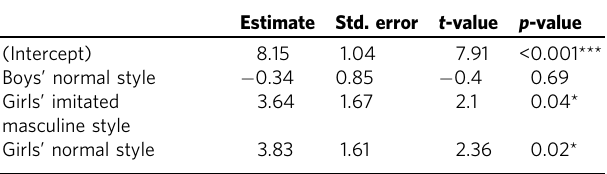
Table 12 Results of the linear-mixed-effects regression model for intensi fi ers.